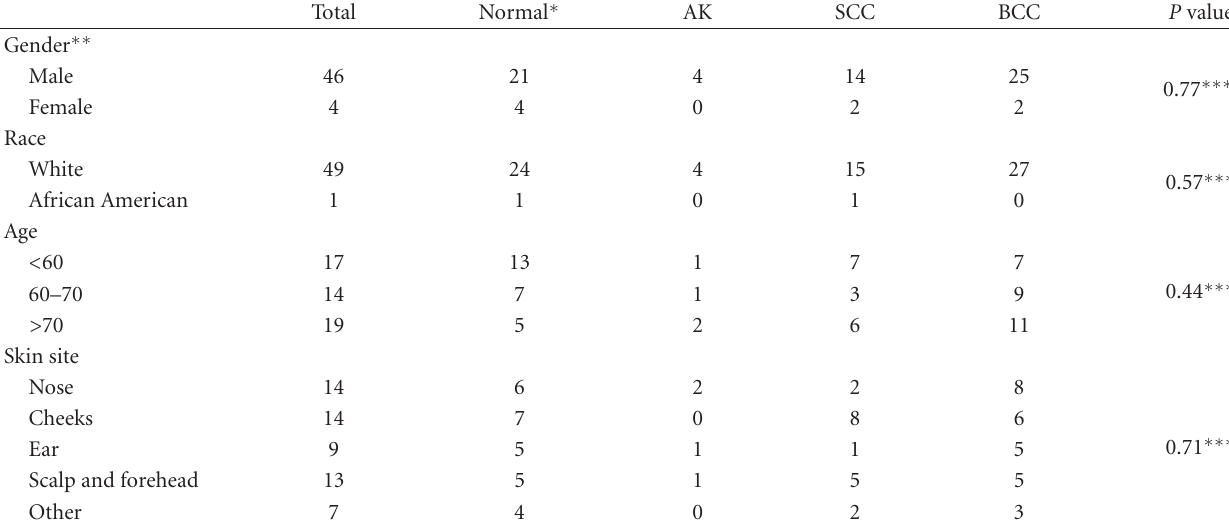
Table 1: Clinical and demographic patient characteristics.